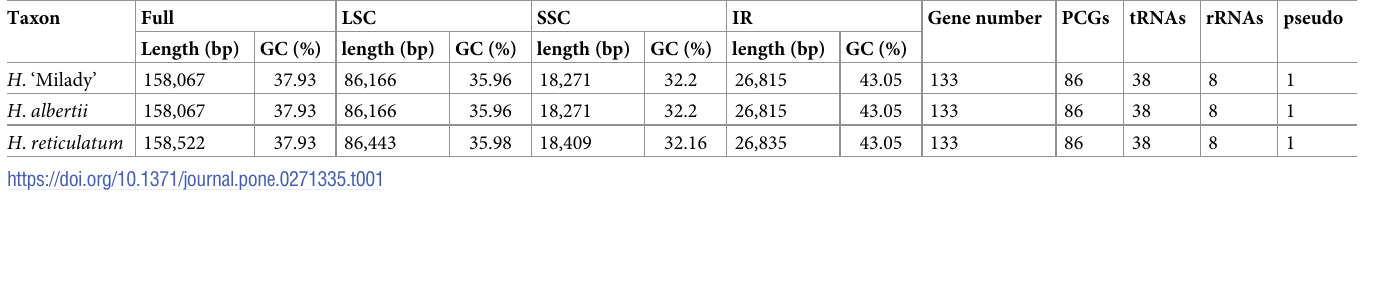
Table 1. Feature of complete chloroplast genomes of Hippeastrum ‘Milady’, H . albertii and H . reticulatum . Taxon Full LSC SSC IR Gene number PCGs tRNAs rRNAs pseudo Length (bp) GC (%) length (bp) GC (%) length (bp) GC (%) length (bp) GC